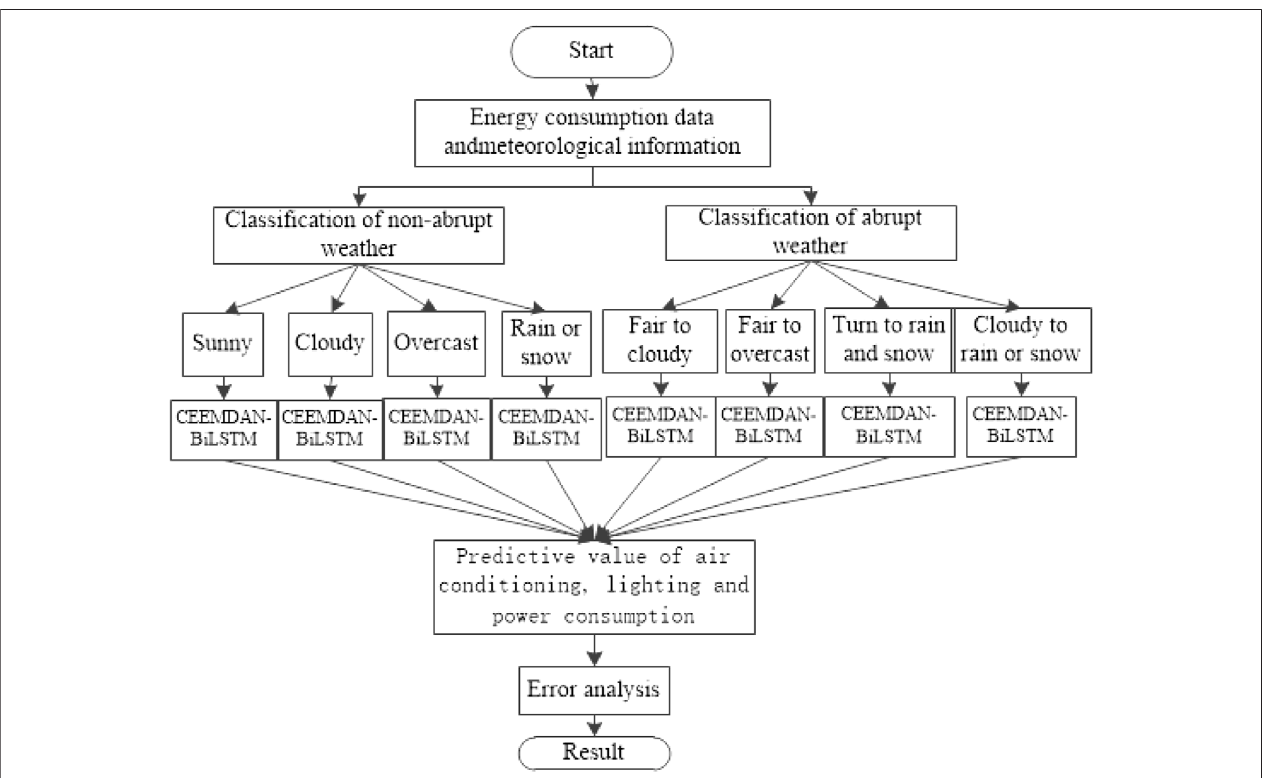
FIGURE 2 | CEEMDAN-BiLSTM model prediction